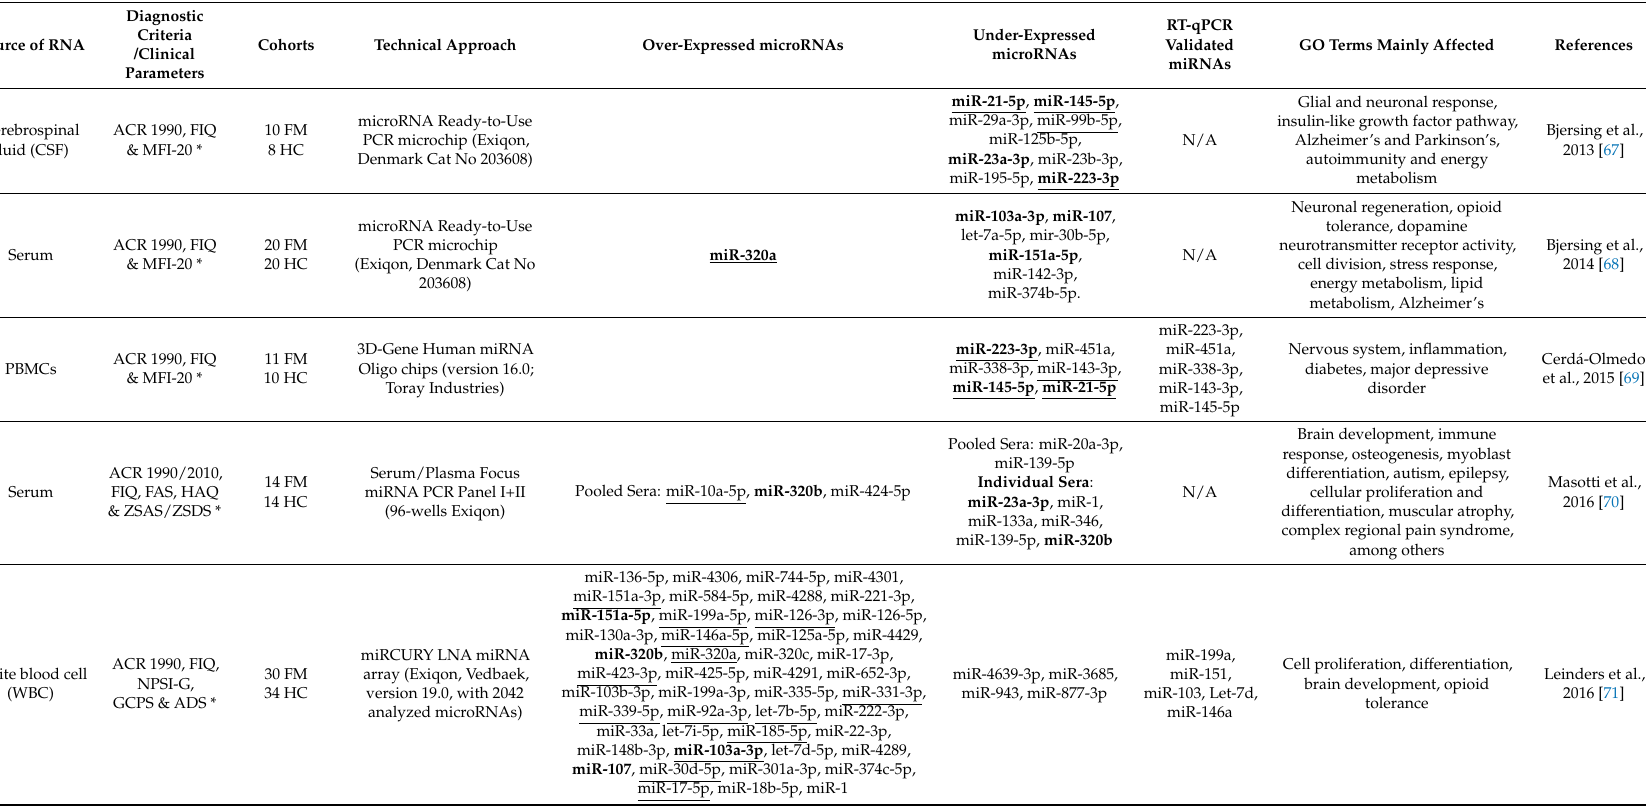
Table 1. Summary of studies evaluating fibromyalgia (FM) miRNomes by multiplex